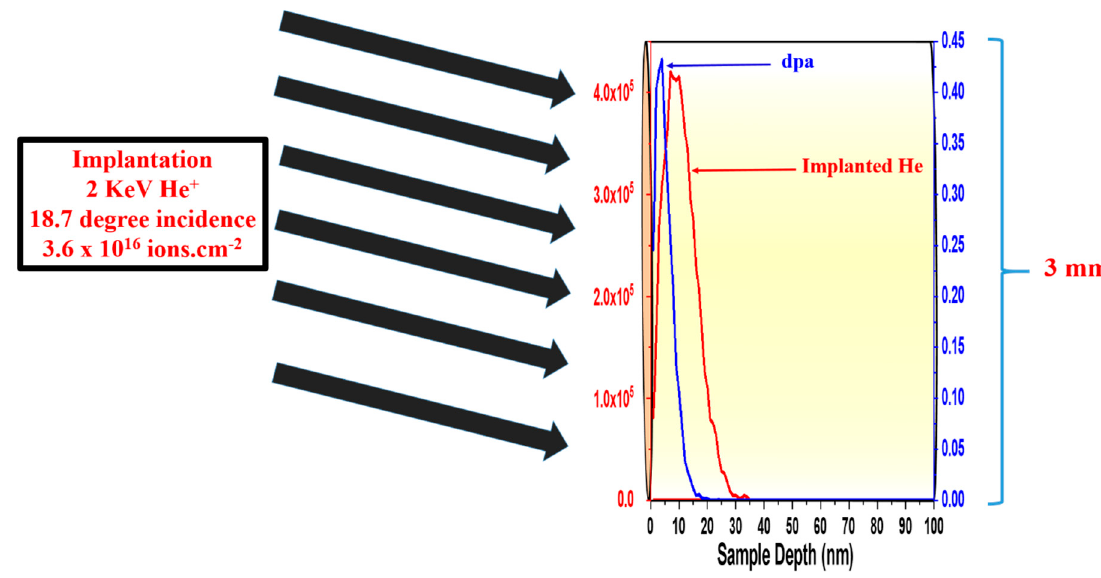
Figure 1. A schematic showing the sample shape, implanted He (red curve), and displacement per atom (dpa) damage (blue curve) distributions of 2 keV He + (as determined by SRIM). The thickness of the sample is magnified for the purpose of overlapping the implanted He and displacement damage distributions. (For interpretation of the references to color in this figure legend, the reader is referred to the web version of this article.)